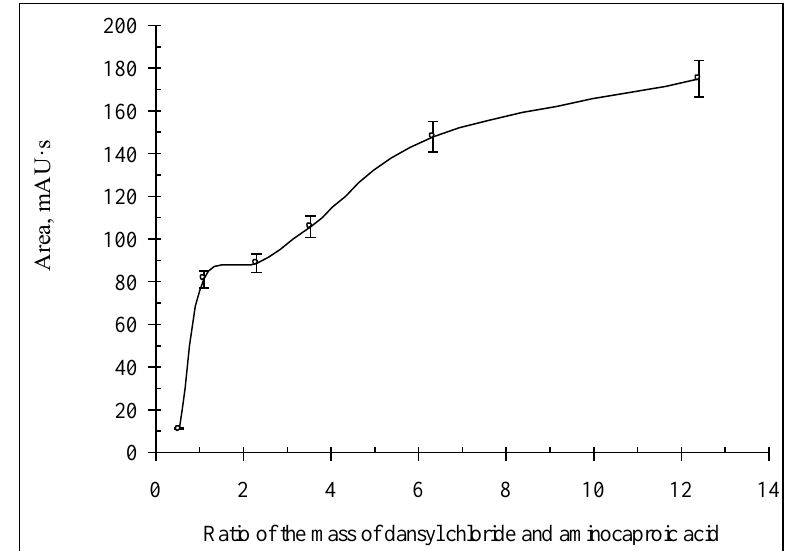
Fig. 6. Dependence of the area of aminocaproic acid derivative on the ratio of mass of dansyl chloride and aminocaproic acid